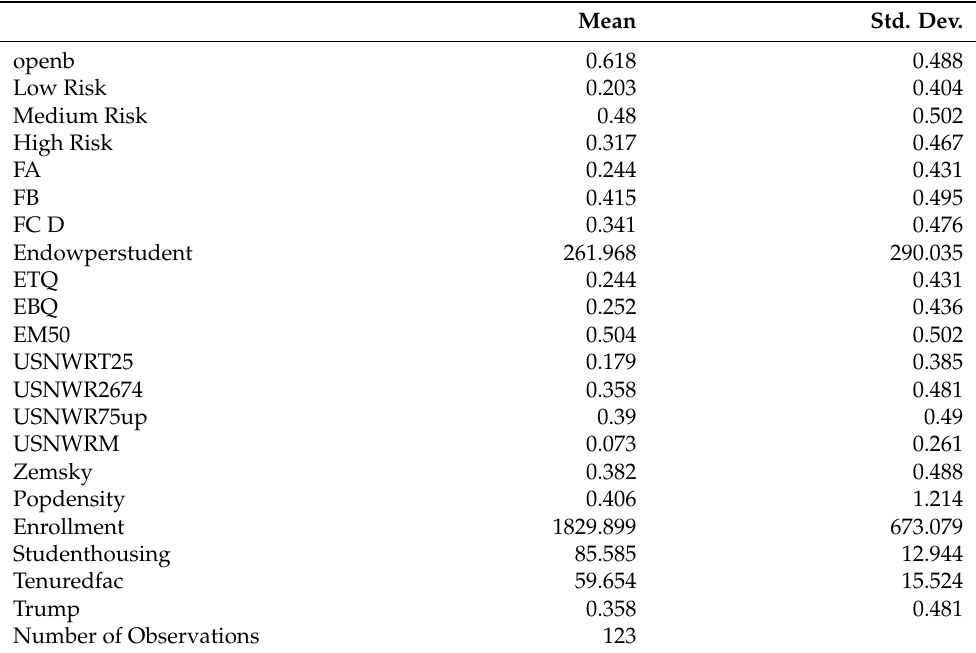
Table 1. Descriptive Statistics.